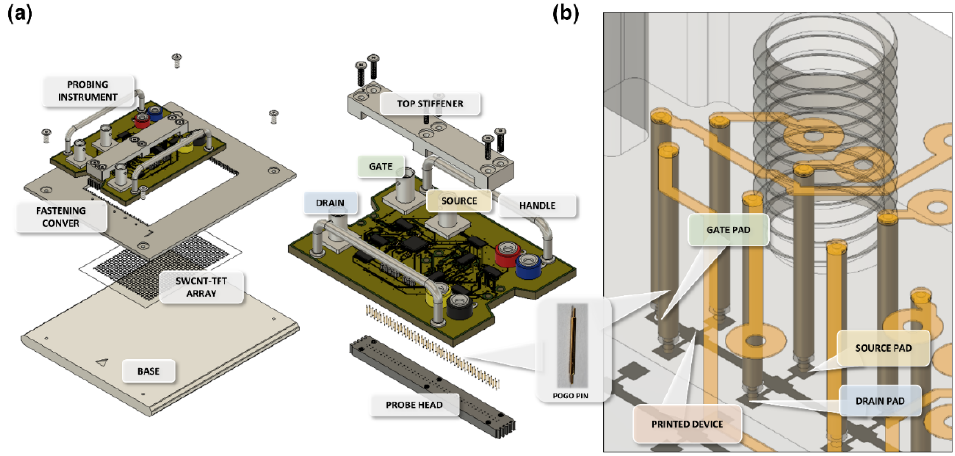
Figure 2. ( a ) Assembly of the PICR2R-TFT probing system. ( b ) Enlarged image for the pin contact structure.